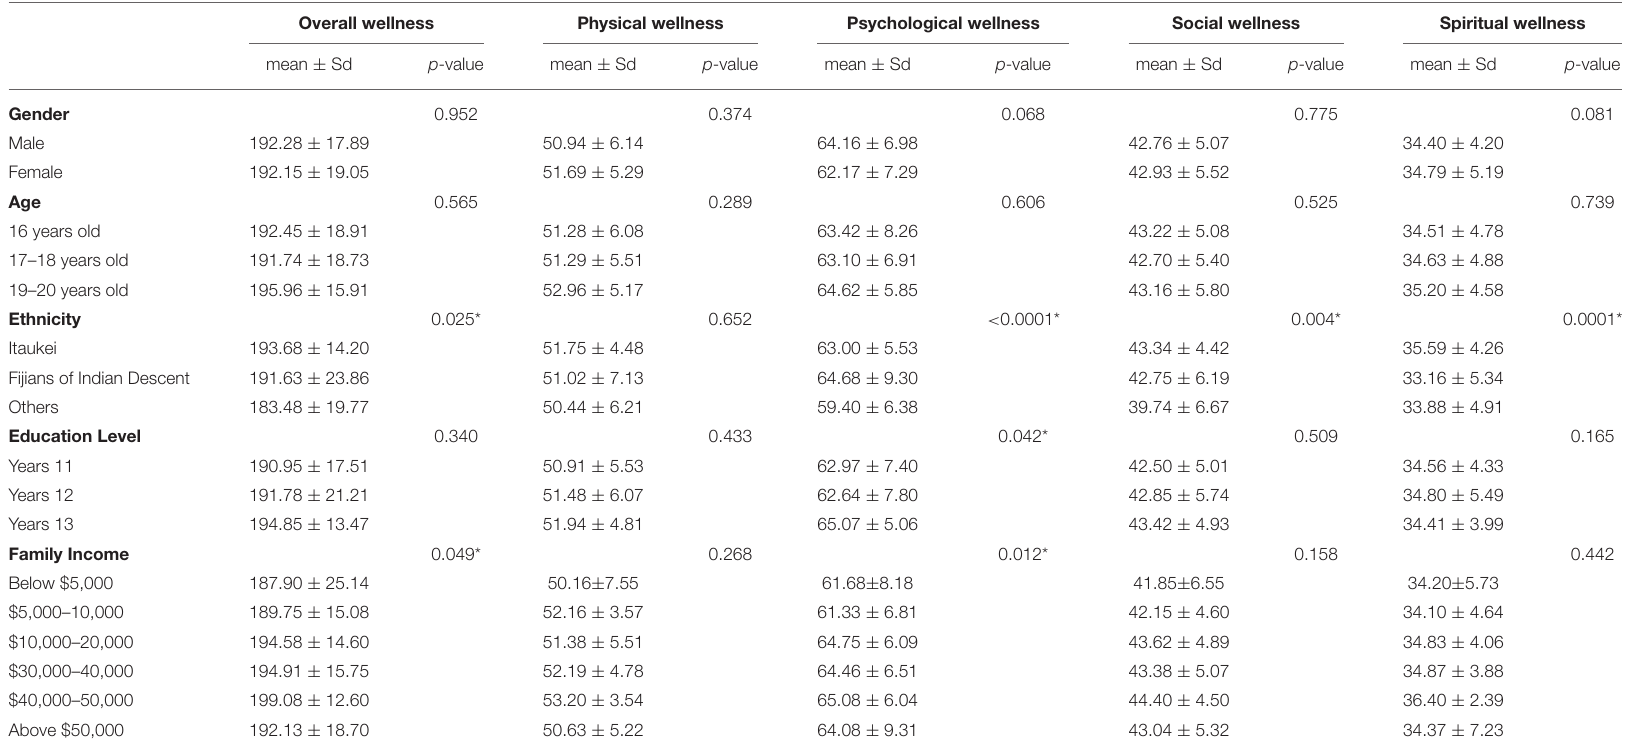
TABLE 3 | ANOVA of demographic variables, wellness composite, and wellness